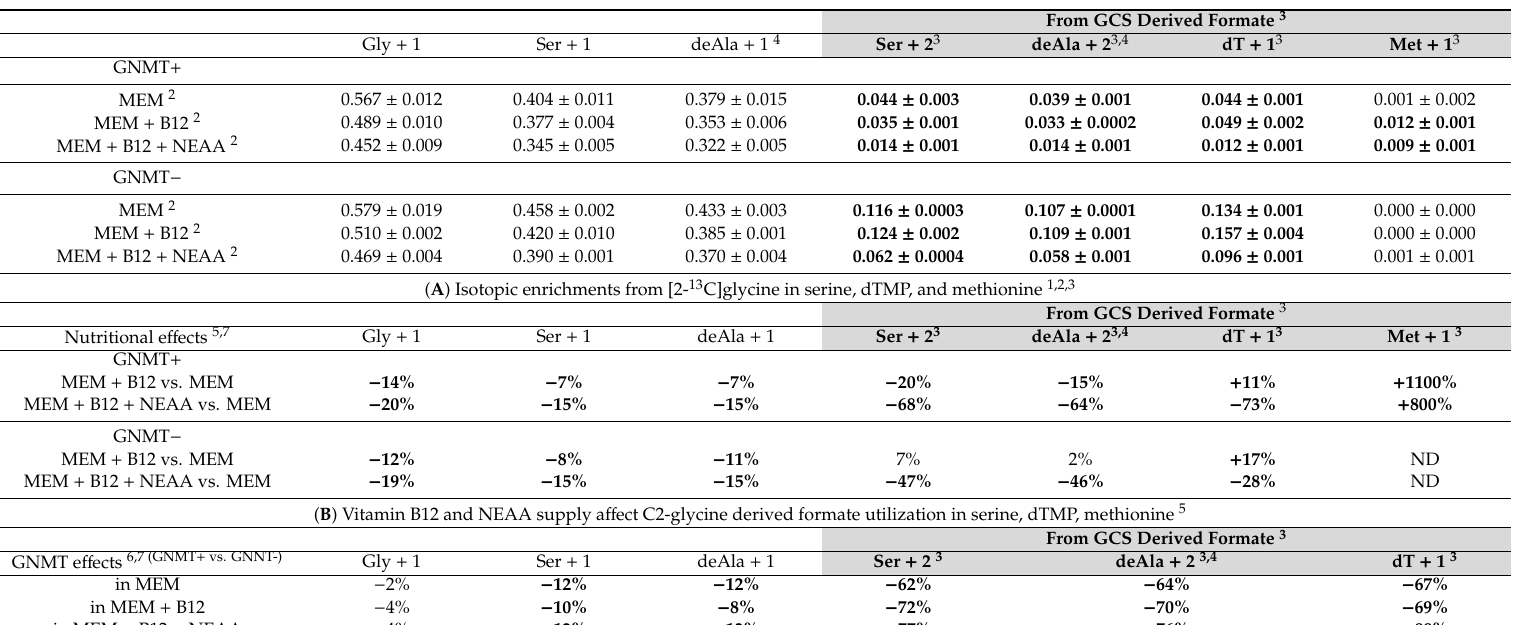
From GCS Derived Formate 3